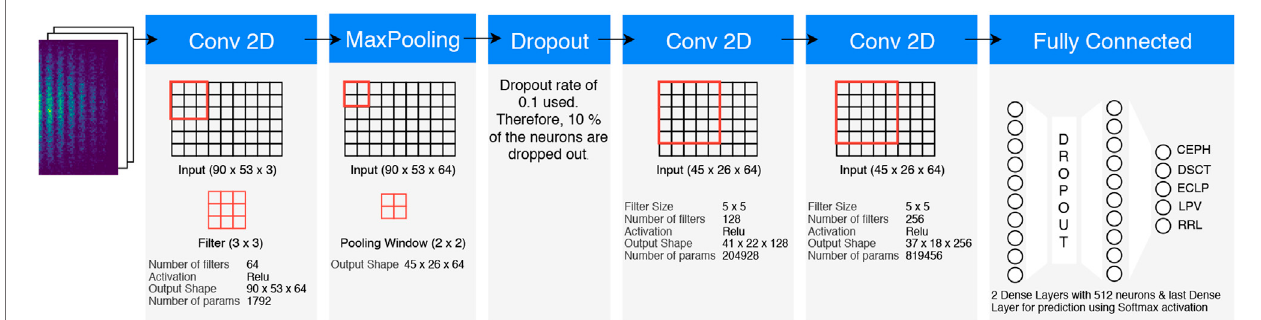
FIGURE 3 | Schematic diagram showing the architecture of Convolutional Neural Network for the OGLE dataset. Different layers in the network are shown as different block and the layer names are indicated at the top of each block. The input images are of shape 90 × 53 × 3. First conv layer uses a kernel size of 3 × 3 but the subsequentlayersusesabiggerkernel sizeof5 × 5to fi ndbiggerpatterns. Thesame architectureisused fortheCRTS dataset exceptthe fi nalclassi fi cation layerwhich instead contains seven nodes corresponding to seven variablity classes present in the CRTS. To update the network parameters while training, we use Adam optimizer (Kingma and Ba, 2014) function with the learning rate fi xed to